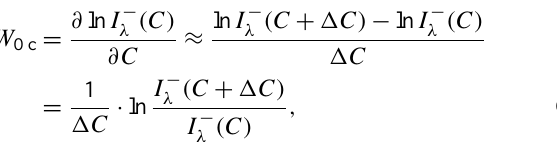
Figure 5. Red: the dimensionless VRS weighting function W V (λ) calculated with SCIATRAN for chl a of 0.1mgm − 3 at a solar zenith angle of 40 ◦ . Green: another weighting function calculated with chl a of 0.5mgm − 3 and scaled by 5. Blue: the oceanic weight- ing function W Oc (λ) excluding VRS scaled by 0.2. All weighting functions are calculated for a change of chl a (cid:49)C = 0 . 01mgm − 3